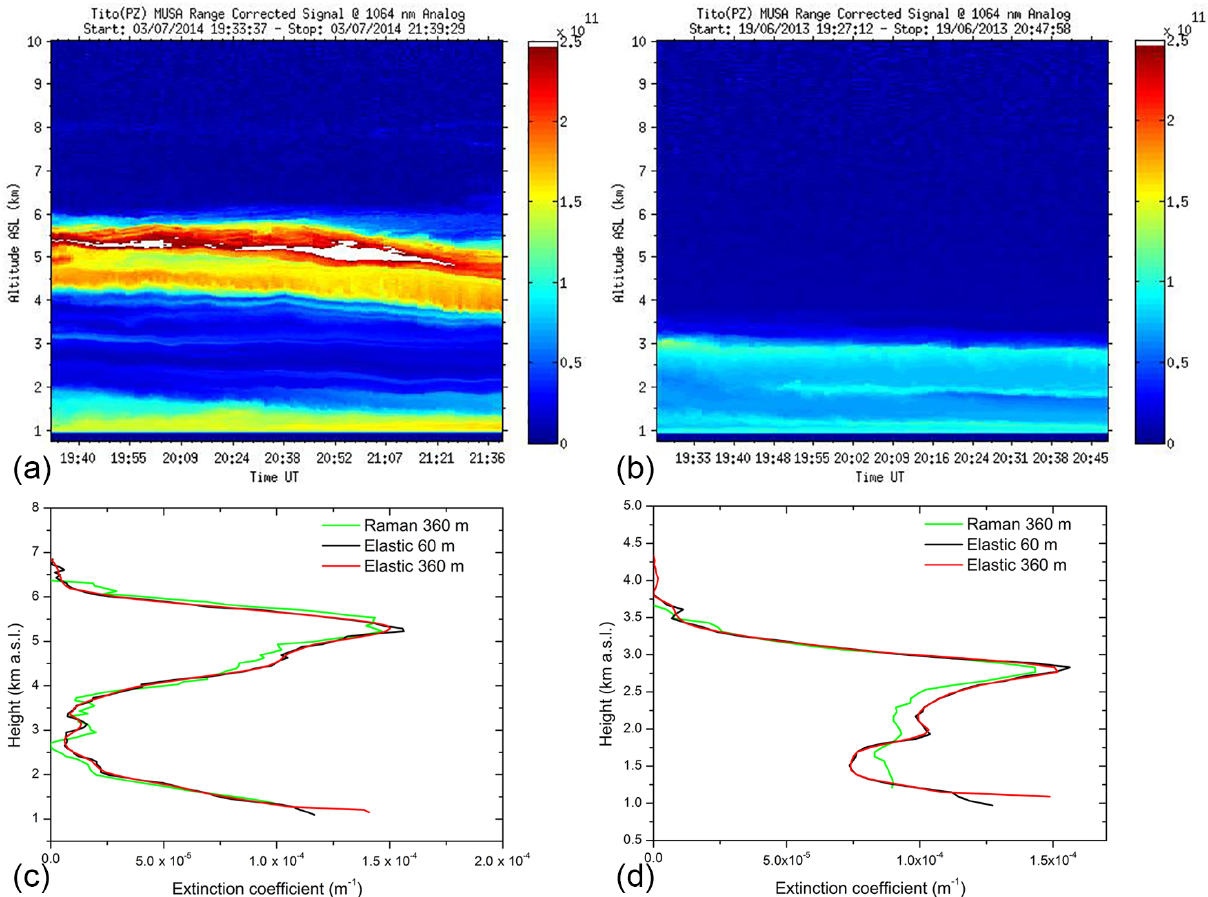
Figure 1. (a) Composite plot of the range-corrected signal at 1064nm showing a well-defined dust layer centered at about 5kma.s.l. (b) and a biomass burning aerosol layer centered at about 2.5km. (c) Aerosol lidar extinction profiles at 355nm retrieved with the Raman (spatial resolution: 360m) and the elastic lidar techniques with different spatial resolutions (60 and 360m) for a dust (signal temporally integrated from 19:34 to 21:40UT) outbreak on 3 July 2014 and for biomass burning (signal temporally integrated from 19:27 to 20:48UT) on 19 June 2013 (d) . The iterative method used a fixed lidar ratio value of S = 57sr, determined by climatological measurements (Mona et al., 2006) for the dust aerosol layer. For the biomass burning we used the averaged value of S = 63sr obtained from the MUSA Raman